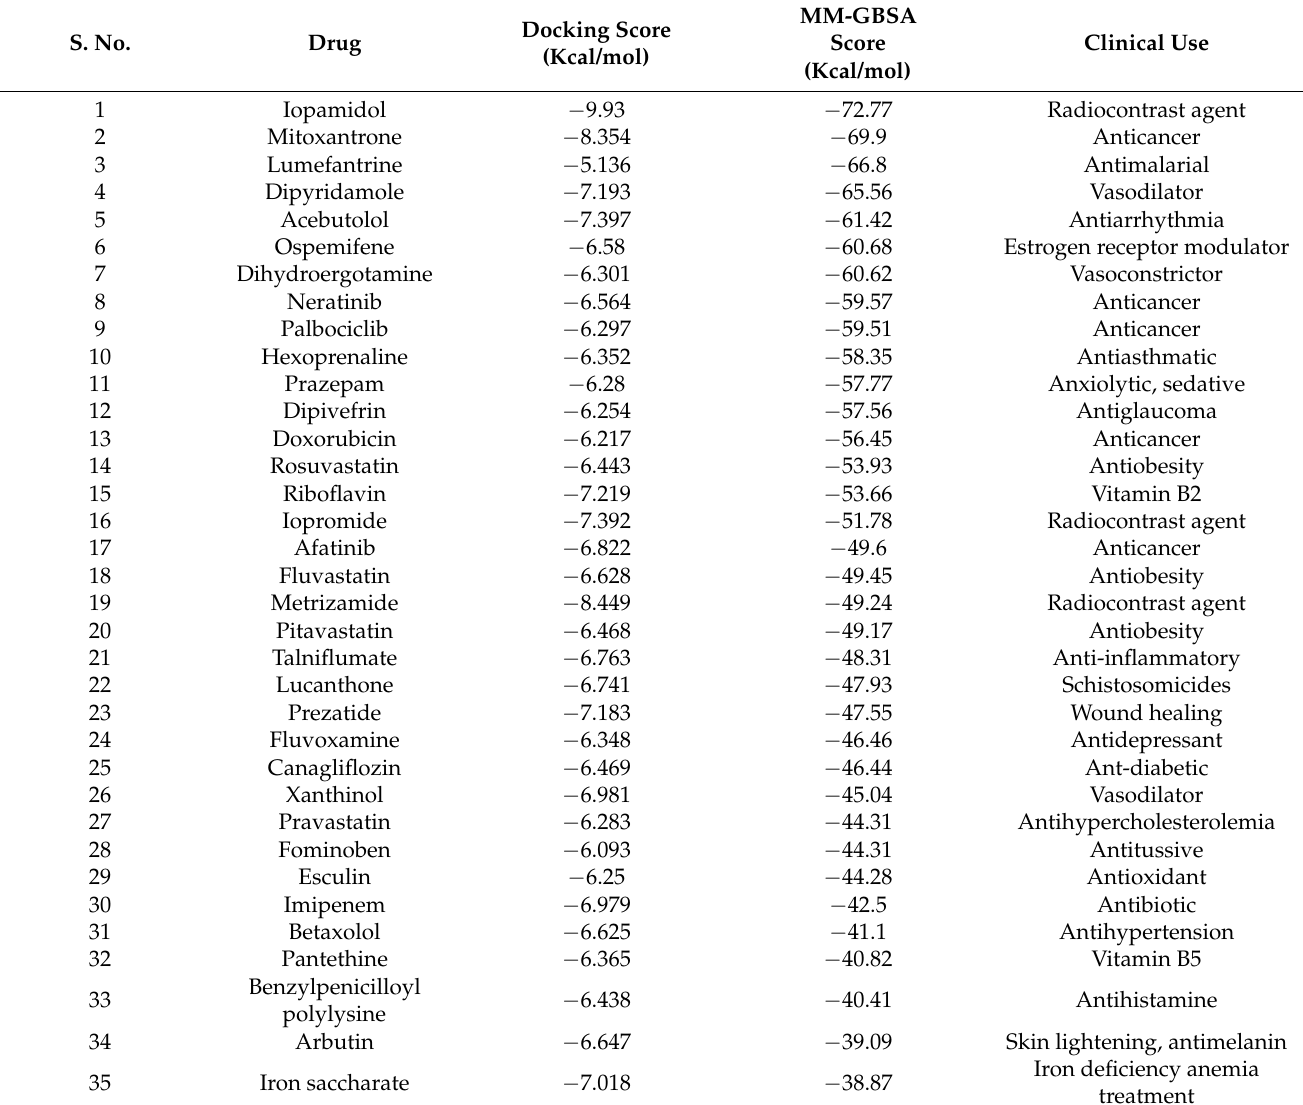
Table 1. List of top-51 hits with their respective docking and MM-GBSA scores and current clinical use of the